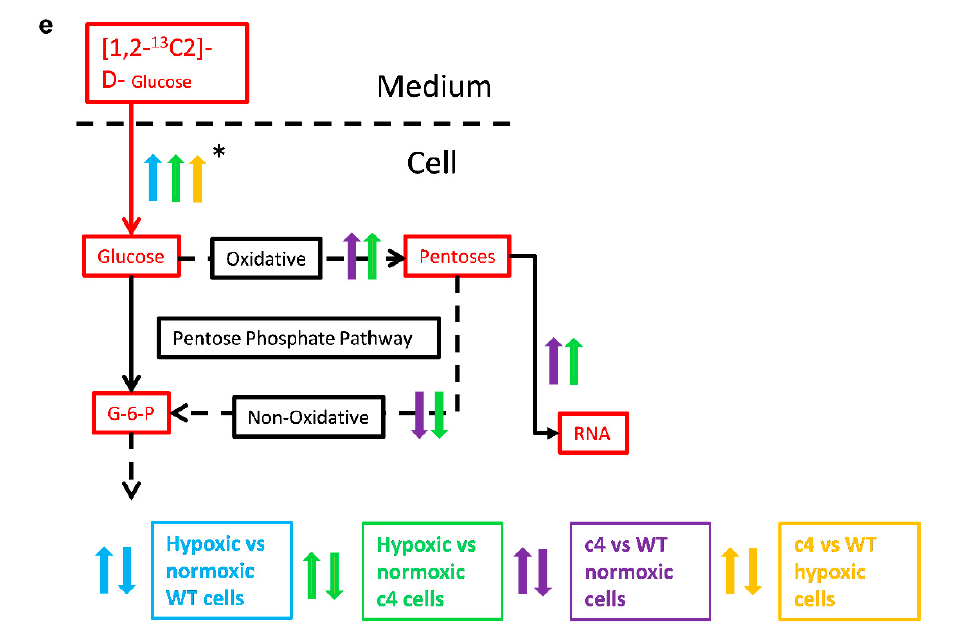
Figure 5. PFAO markers and differences in pentose phosphate pathway flux in Hepa-1 cells. ( a ) Acetate content significantly increased in Hepa-c4 cells in response to hypoxia ( p < 0.05, n = 5). ( b ) Hypoxic Hepa-c4 cells released more hydrogen peroxide into the media ( p < 0.05, n = 5) ( c ) Nucleic acid ribose synthesis via the oxidative pentose phosphate pathway was higher in Hepa-c4 than WT cells in both normoxia and hypoxia ( p < 0.02 and p <0.01, respectively, n = 4). ( d ) Nucleic acid ribose re-assembly via the non-oxidative pentose phosphate pathway was slightly lower in Hepa-c4 than WT cells ( p < 0.05), but was not substantially affected by hypoxia in either cell line. ( e ) Diagram showing flux differences and changes between the two Hepa-1 cell types in normoxia and hypoxia. N, normoxia; H, hypoxia (1% O 2 ); arrows pointing upwards suggest significant increase for a given comparison. * Indicates differences in metabolic flux ( ↑ increased flux; ↓ decreased flux) due to HIF deficiency and hypoxia, which were inferred from changes in the relevant 13 C-labelled isotopomers; * ↑ and * ↓ fluxes were inferred from concentration changes in the substances indicated, not their 13 C-labelling. Panels ( a – e ) show data expressed as mean ± SEM; statistical significance assessed by unpaired two-tailed